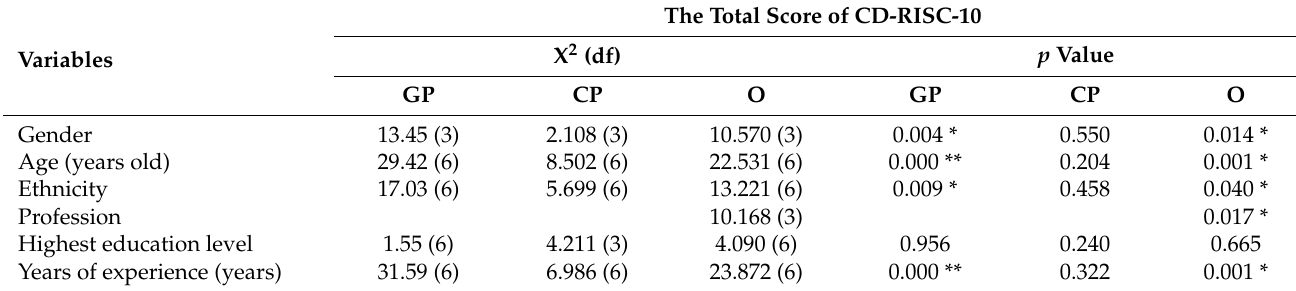
Table 5. Associations of independent variables with CD-RISC-10.